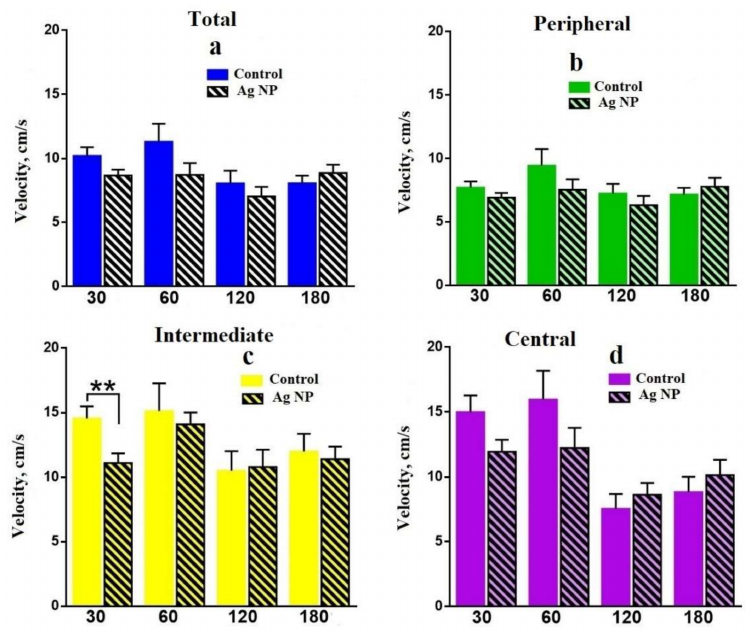
Figure 6. Mean velocity: total ( a ); in the Peripheral area ( b ); in the Intermediate area ( c ); in the Central area ( d ).